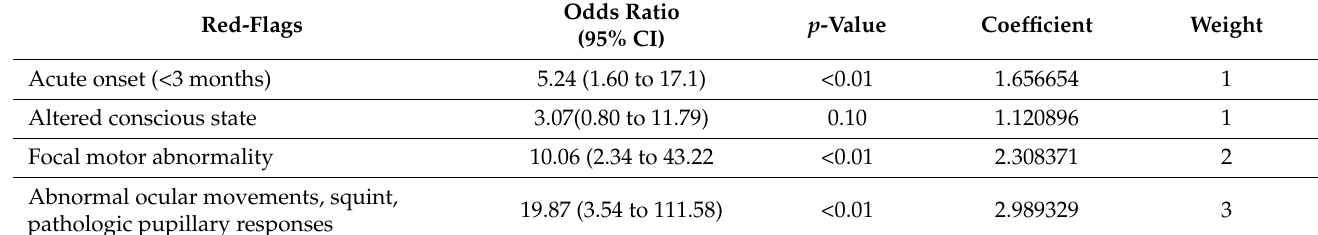
Table 4. Clinical Predictors for Emergent Intracranial Lesions in Children with non-traumatic Headaches.